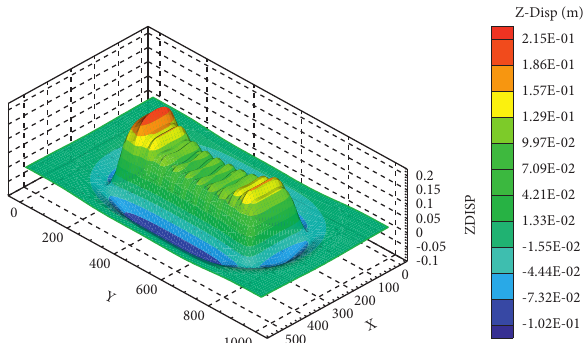
Figure 16: The simulation diagram of the displacement change of the protected bottom plate.